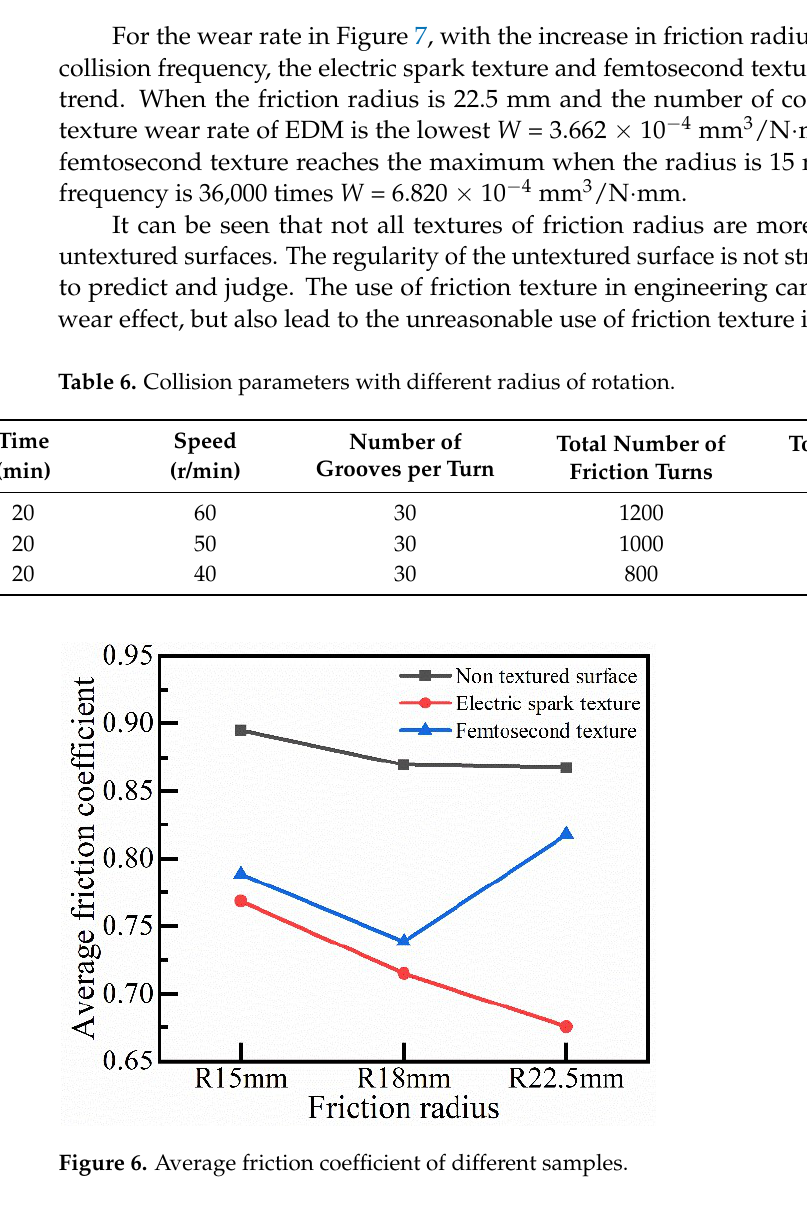
Figure 7. Wear rate of different samples. 3.2. Worn-Morphology Analysis After the friction experiment, the flaked convex part formed on the surface of the friction pair is called the hard-phase peak [34]. The hard phase peak may be the migration of wear debris under the combined action of load and sliding speed during the friction process. Heat is generated rapidly during friction, and it is cooled rapidly during friction pair collision. Under this repeated action, it is formed by gluing and “cold welding”, which is similar to cold-work hardening. According to the position of hard-phase peak, it can be divided into wear-mark hard-phase peak and wear-mark-edge hard-phase peak. The hard-phase peak at the edge of the wear mark helps to form a supporting effect on the surface of the friction pair, which could protect the surface from further wear. The